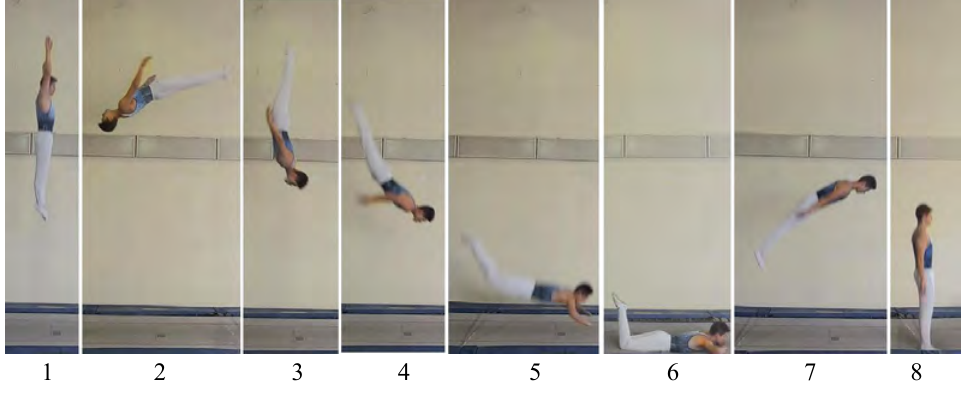
Fig.12. Back somersault, straightening with landing on